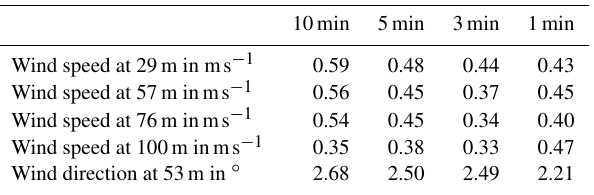
Table 6. Standard deviations of measured wind speed and wind di- rection for averaging periods of 1, 3, 5 and